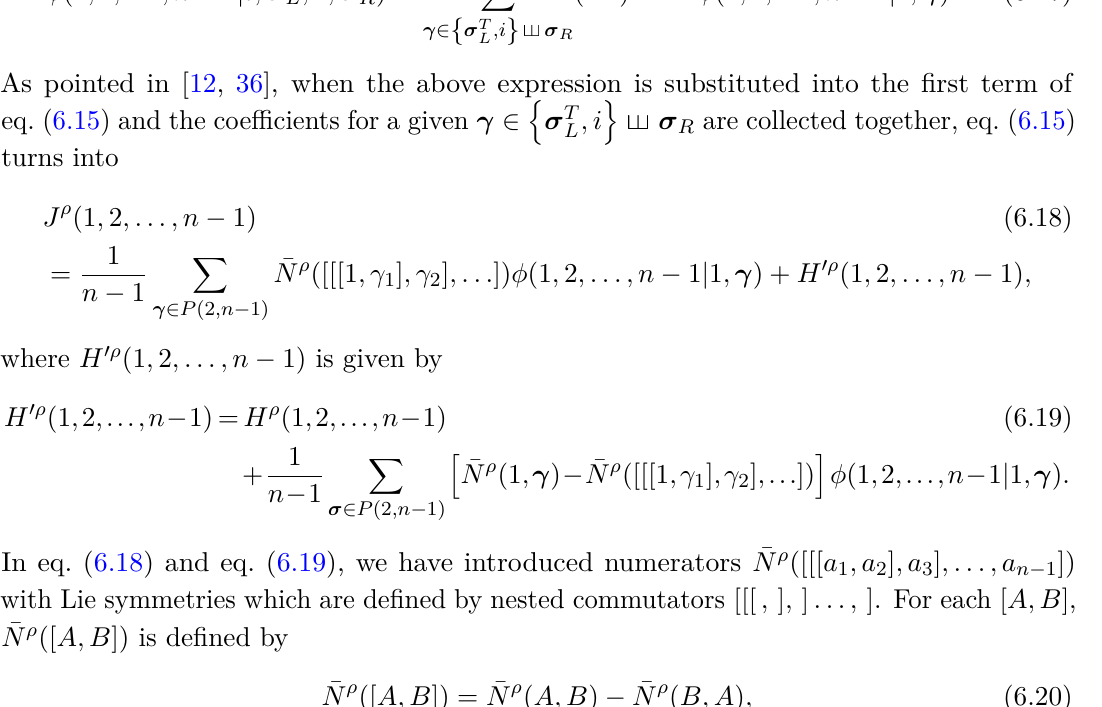
Figure 16 . A binary graph which describe the antisymmetric object are substructures (which may also be expressed by binary graphs) attached to a same cubic vertex. A (1 , 2 , . . . , n ) . 8 As a result, the H 0 ρ (1 , 2 , . . . , n − 1) has to vanish in the on-shell